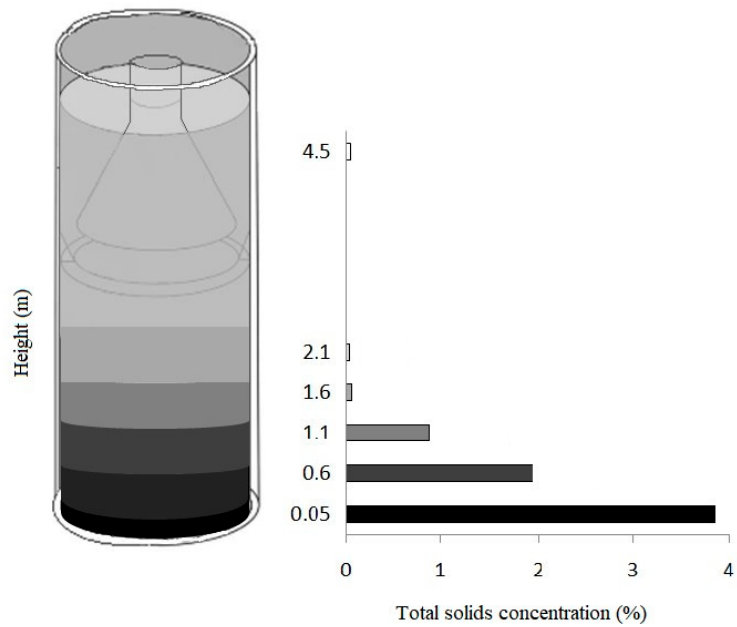
Figure 4. Solids profile inside the demo-scale UASB reactor obtained by gravimetric analysis.